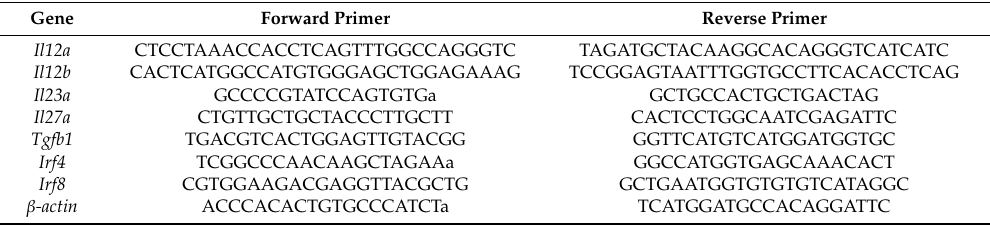
Table 1. List of the primers used for qPCR